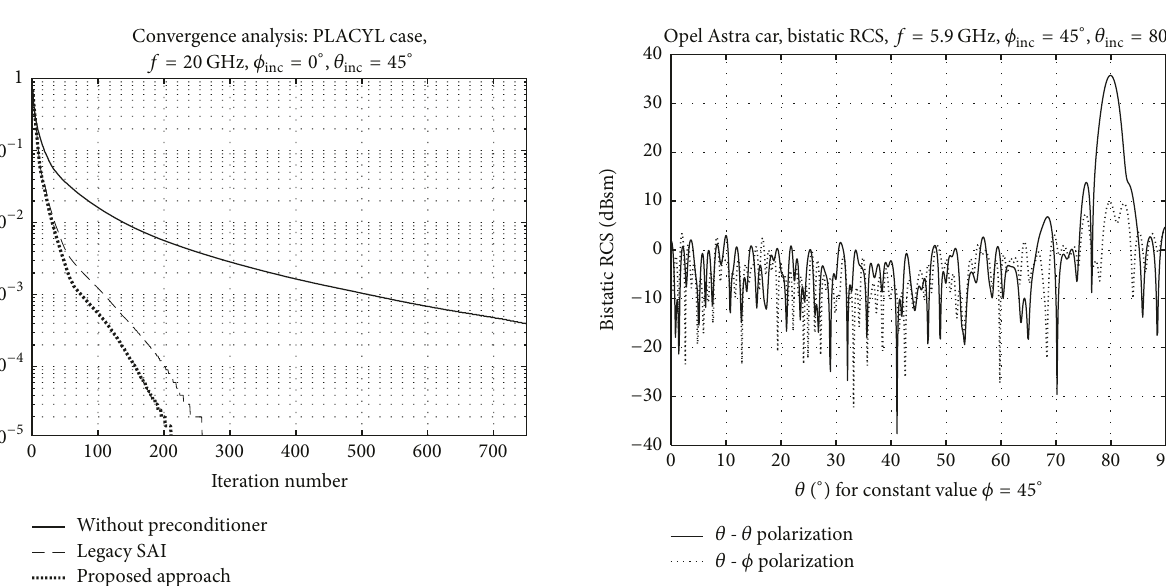
complex geometrical models. The inclusion of very small patches, degenerate surfaces, and other sublambda details produces an irregular mesh that favors slower convergence rates. In addition, the use of dielectric materials assigned to some of the surfaces of the model combined with PEC surfaces in the rest of the body also poses a burden to the convergence properties of the problem. In this case the conventional SAI approach did not reach convergence and stalled with an error value of 2.2 ⋅ 10 −2 . The conventional SAI preconditioner uses the same sparsity pattern as the near field coupling matrix, which is in essence equivalent to generating the preconditioner using a sparsity distance of 𝜉 = 0.25 𝜆 in this case. However, due to the features of this geometrical model the resulting preconditioner does not adequately resemble the inverse of [𝑍 NF ] . The extended value of the sparsity distance used with the proposed approach ( 𝜉 = 0.75 𝜆 ) allows the computation of a denser preconditioner that provides better convergence. The total simulation time